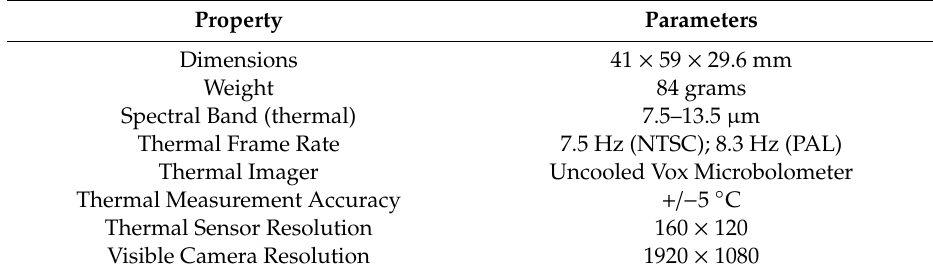
Table 2. Technical specifications of FLIR DUO R dual-sensor